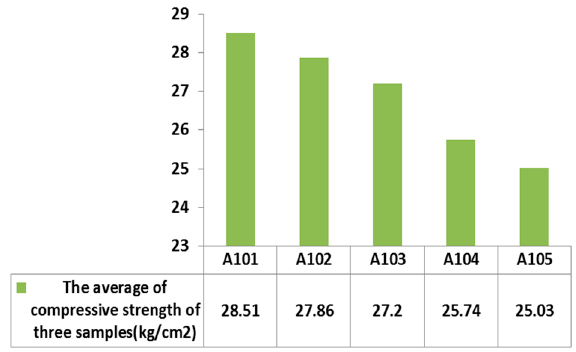
Figure 7. The test results of the compressive strength (kg/cm 2 ).